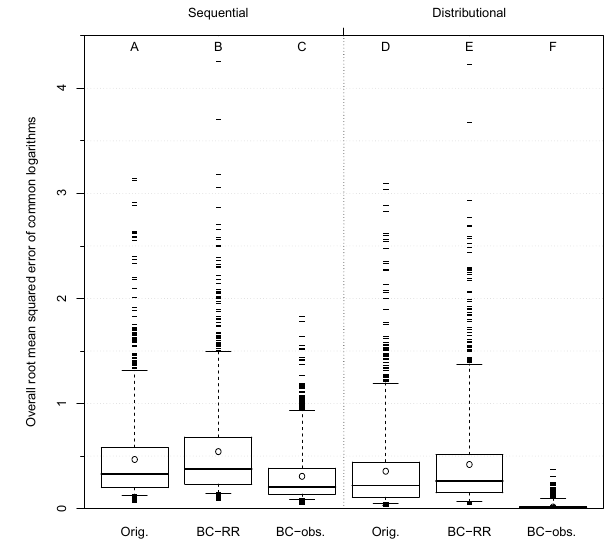
Figure 3. Distribution of logarithmic bias, measured as the mean difference between the common logarithms of simulated and ob- served streamflow (simulated minus observed) at 1168 streamgages across the conterminous USA. Orig. refers to the original simula- tion with pooled ordinary kriging, BC-RR refers to the Orig. hydro- graph bias-corrected with regionally regressed flow duration curves, and BC-Obs. refers to the Orig. hydrograph bias-corrected with ob- served flow- duration curves. The tails of the box plots extend to the 5th and 95th percentiles of the distribution; the ends of the boxes represent the 25th and 75th percentiles of the distribution; the heav- ier line in the box represents the median of the distribution; the open circle represents the mean of the distribution; outliers beyond the 5th and 95th percentile are shown as horizontal dashes.